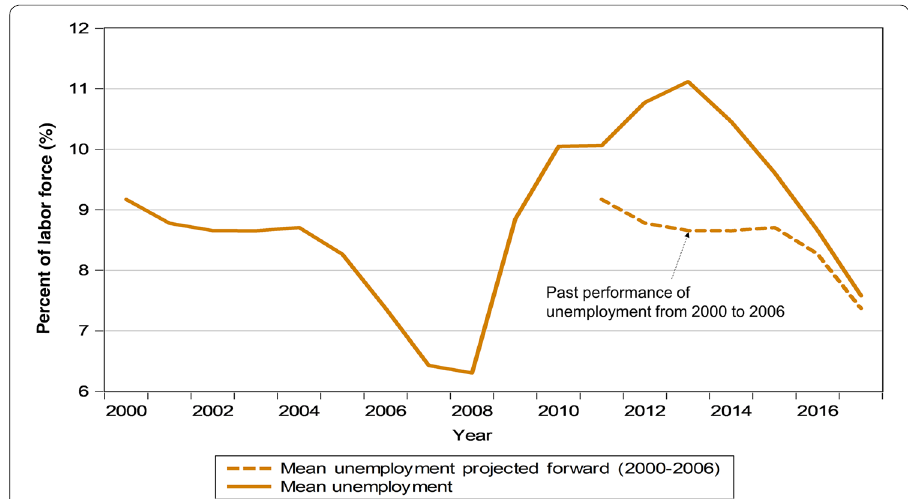
Fig. 3 Analogy of unemployment experience identified from two distant periods. The unemployment data on the 28 EU countries are sourced from the World Development Indicators database (2019) of the World